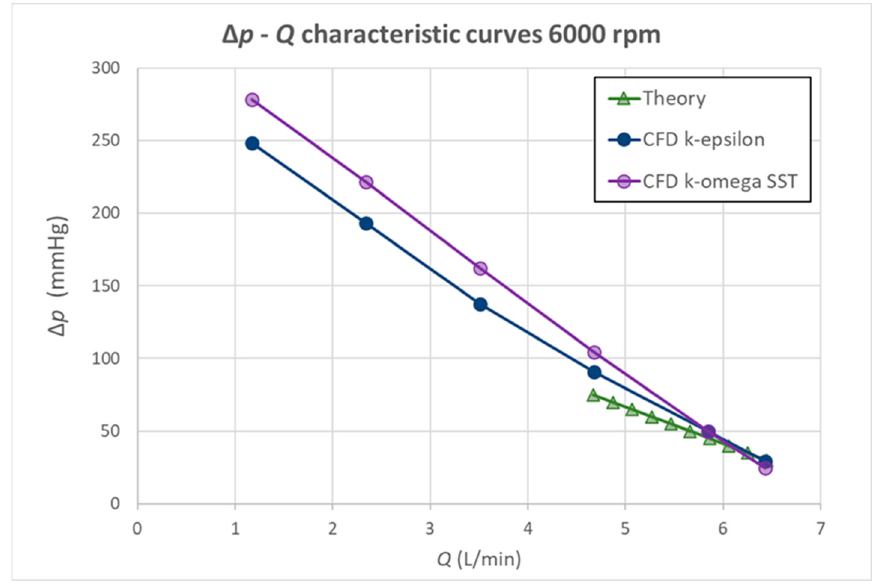
Figure 8. ∆ p - Q characteristic curves.